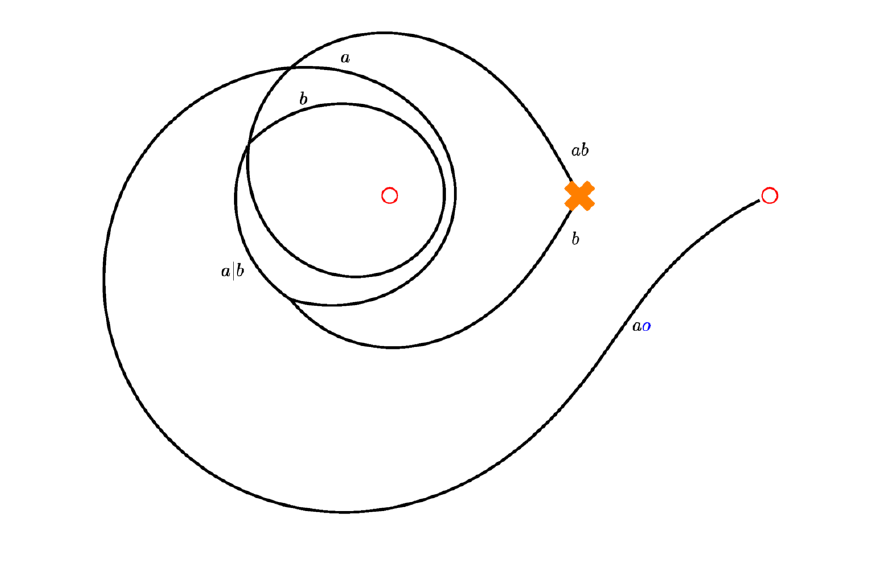
Figure 55. Bound state of the D4 brane with two D0 branes.